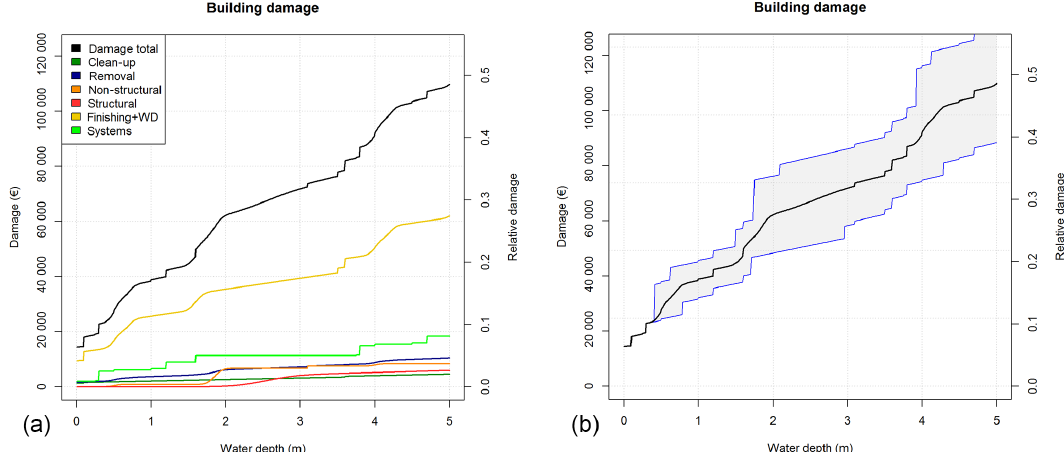
Figure 3. Example of INSYDE damage functions considering the following event variables: flow velocity = 2.0ms − 1 , flood duration = 24h, sediment concentration = 0.05, and water quality = presence of pollutants. (a) Damage functions for entire building and different building components. (b) Total building damage function with 5th and 95th percentiles of modelled damages representing uncertainty due to damage mechanisms.